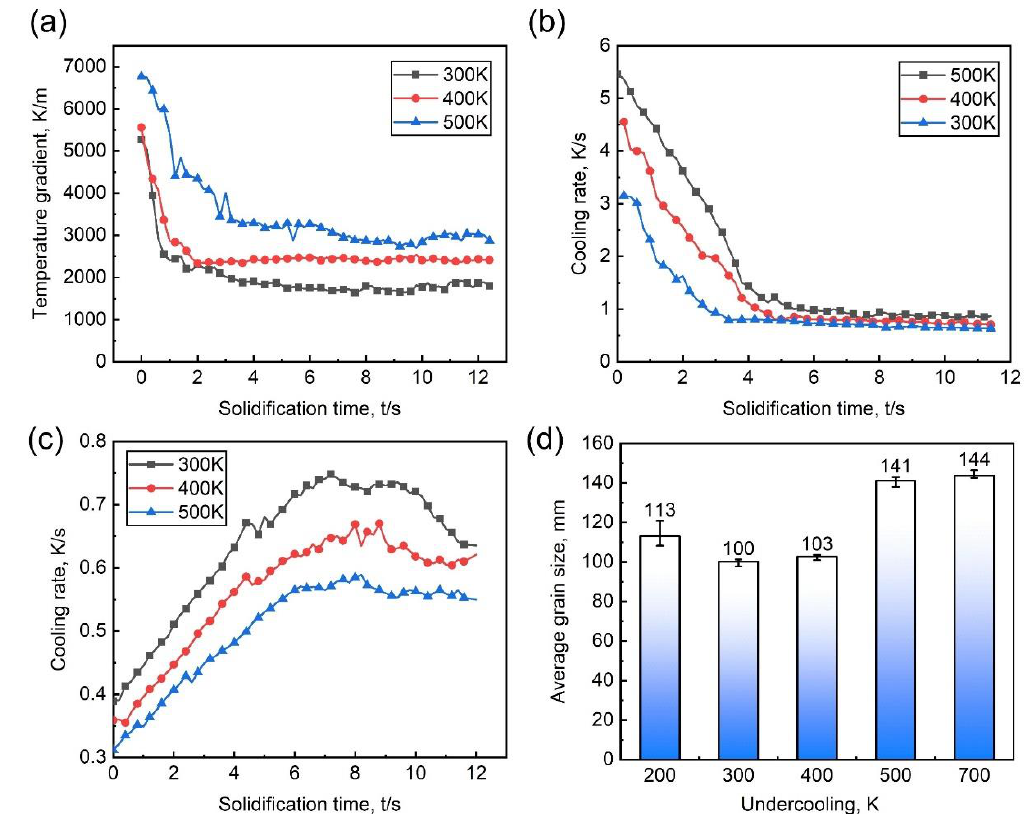
Figure 7. Quantitative analysis of temperature field distribution characteristics and grain size information. ( a ) The temperature gradient distribution between two A and B points, as illustrated in Figure 4a. ( b ) The cooling rate curve of point A. ( c ) The cooling rate curve of point B. ( d ) The average grain size under different degrees of undercooling on the surface of the crystal nucleus generator.